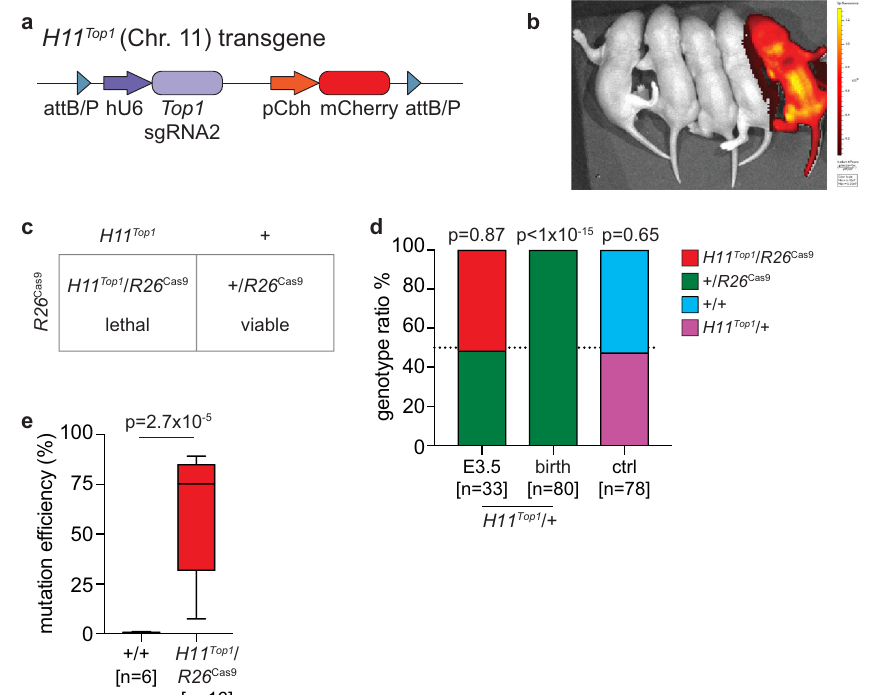
Fig. 2 Generating and examining the functionality of the H11 Top1 mouse. a Schematic of H11 Top1 transgenic locus. b mCherry in vivo imaging showing H11 Top1 mouse (far right). Raw data images provided as a Source Data fi le. c Mating strategy. d Offspring from matings between H11 Top1 / + males and either homozygous R26 Cas9 females ( fi rst two columns) or control wild-type females (right column). n = number of offspring. p -value shows the signi fi cance of deviation from 1:1 ratio (Chi-squared test). e Top1 mutation ef fi ciency in E3.5 wild-type ( + / + ) and H11 Top1 / R26 Cas9 embryos (median = 75%). Box plots describe minima, maxima and median with error bars (s.d.). p -value; two-tailed Mann – Whitney test, n = number of embryos). sgRNA single guide RNA, Top1 Topoisomerase 1, pCbh hybrid CBA promoter, ctrl control, E embryonic